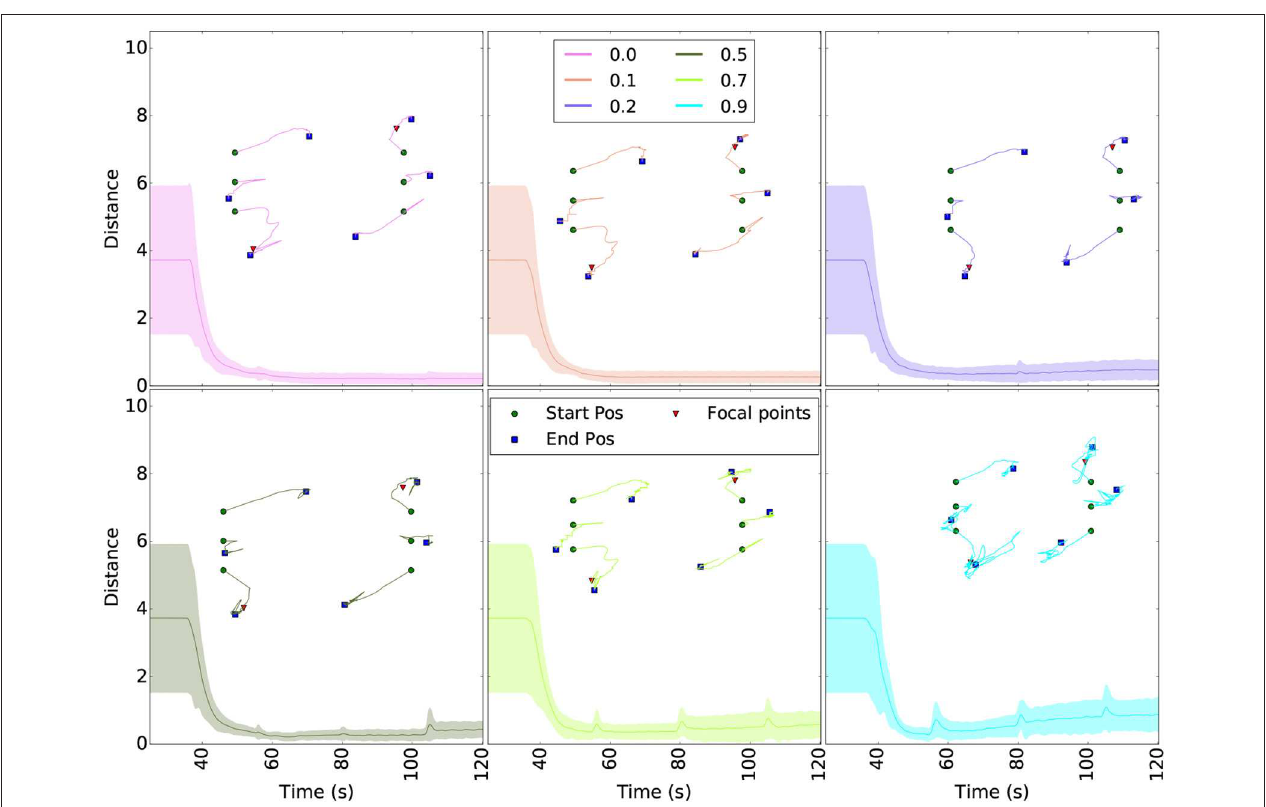
FIGURE 12 | Robustness to packet drop in communication for the coverage algorithm. The curves show the distance to the ideal Voronoi cells centroids (taken as the one without packet lost) and robot trajectories for different packet drop rates. The starting positions (green dots), final formation (blue squares) and hotspots (red triangles) are plotted above the curves. Each scenario was ran 5 times and the colored area around the curves show the variability of the results. Even with 90% packet drop rate, the swarm converge to the right cell